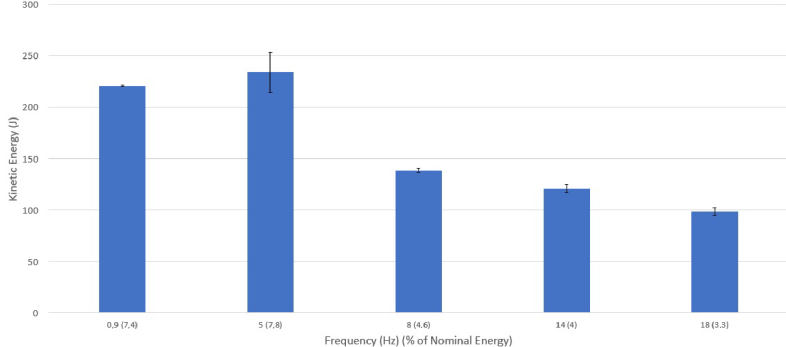
Figure 19. Dependence of kinetic energy on impact frequency (Mayer [114]).